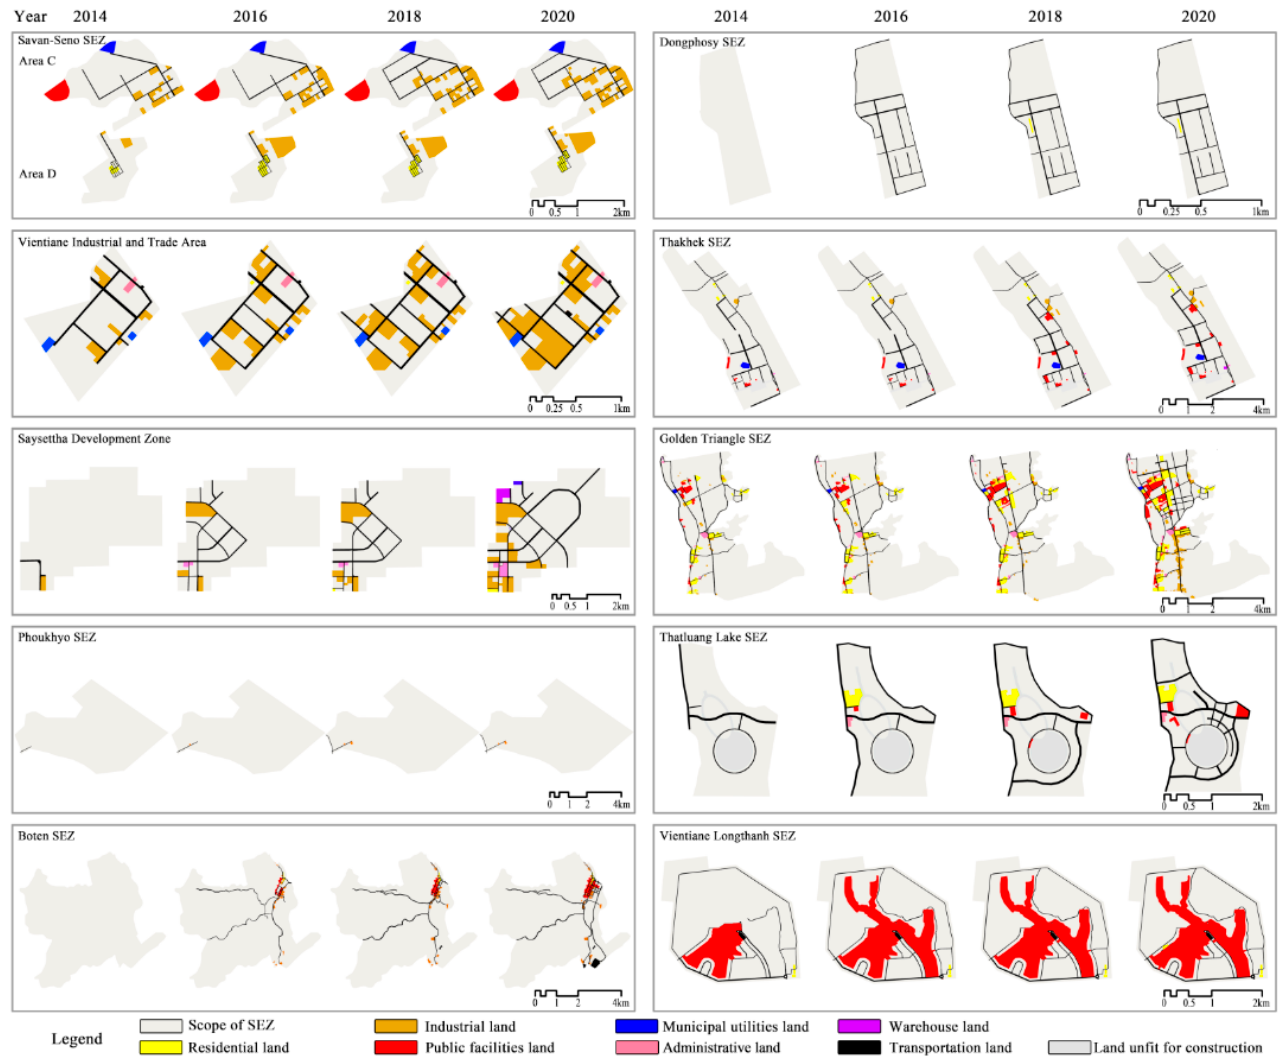
Figure 5. Evolution of the land-use structure in Laos’ SEZs. The development rates in Zones A and B of the Savan-Seno SEZ are low, and the evolution of the land-use structure is not obvious, so the data are not shown in the figure.